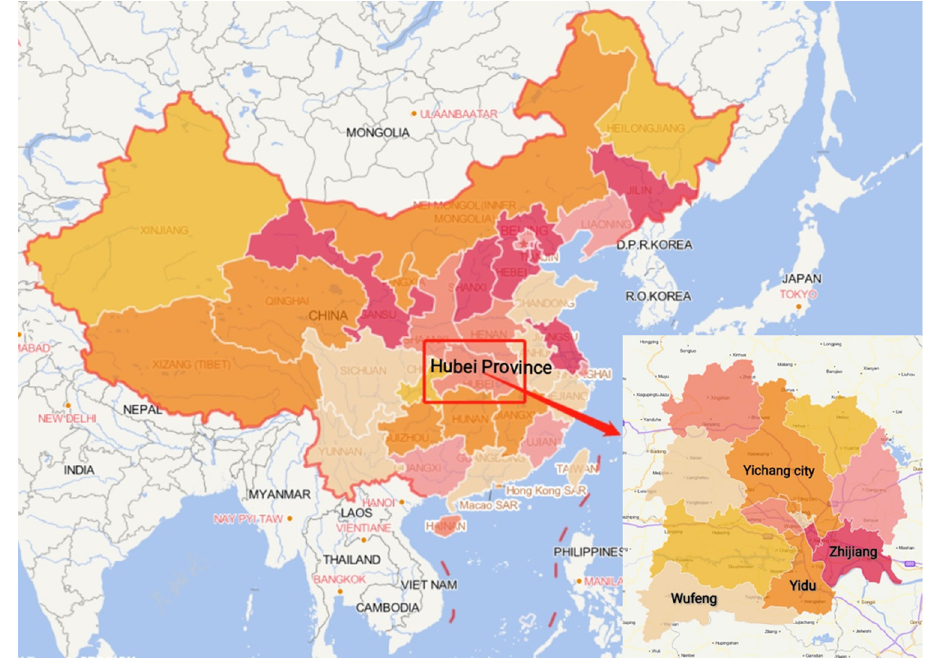
Figure 1. Location of sample counties in Yichang city. Data source: Map World, https://zhfw.tianditu.gov.cn/.